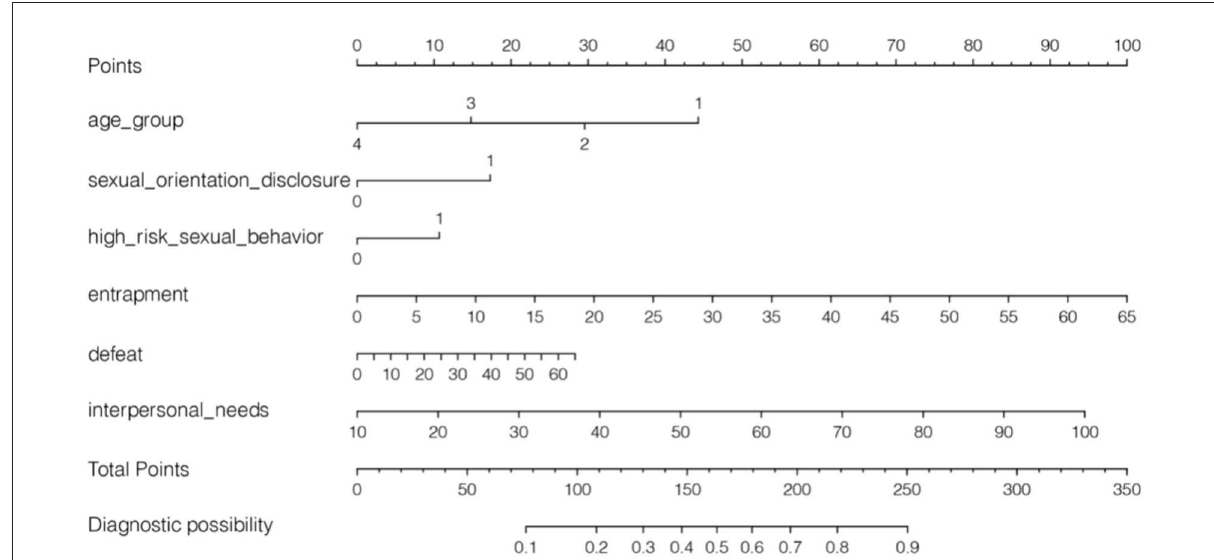
FIGURE2 Developed nomogram of suicidal ideation based on the training set. Age group: 1 = ≤ 29; 2 = 30–39; 3 = 40–49; 4 = ≥ 50; sexual orientation disclosure, 1 = yes; 0 = no; high-risk sexual behavior, 1 = yes; 0 =